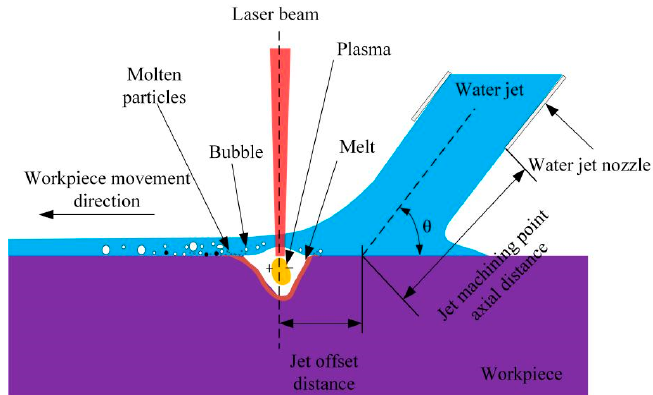
Figure 10. Schematic of water-jet-assisted laser